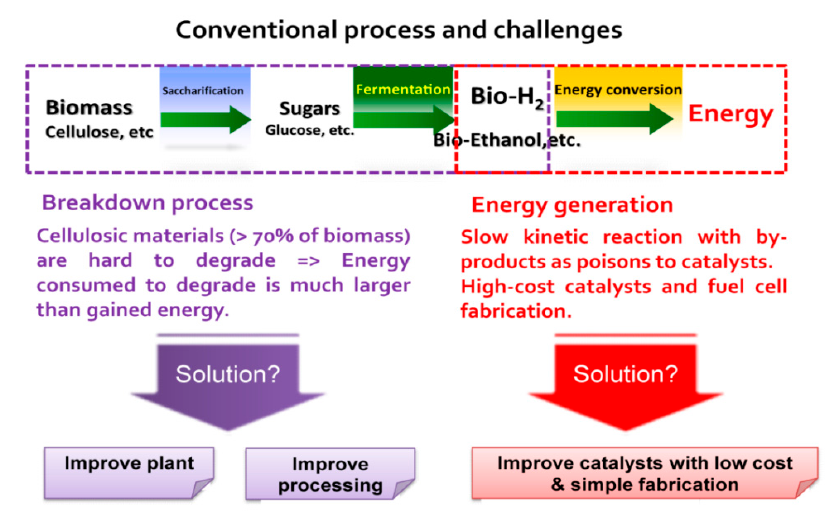
Figure 1. The conventional process and challenges in converting biomass sources into biofuels and ultimately generate energy in form of electricity.